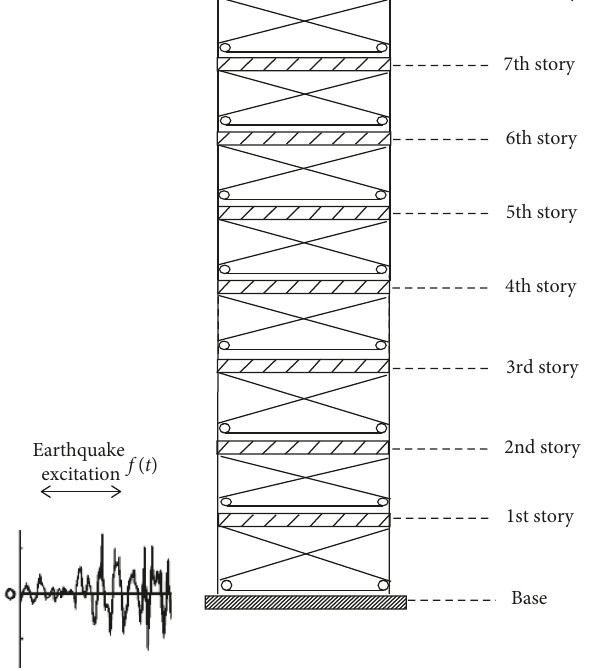
Figure 2: Eight-story shear